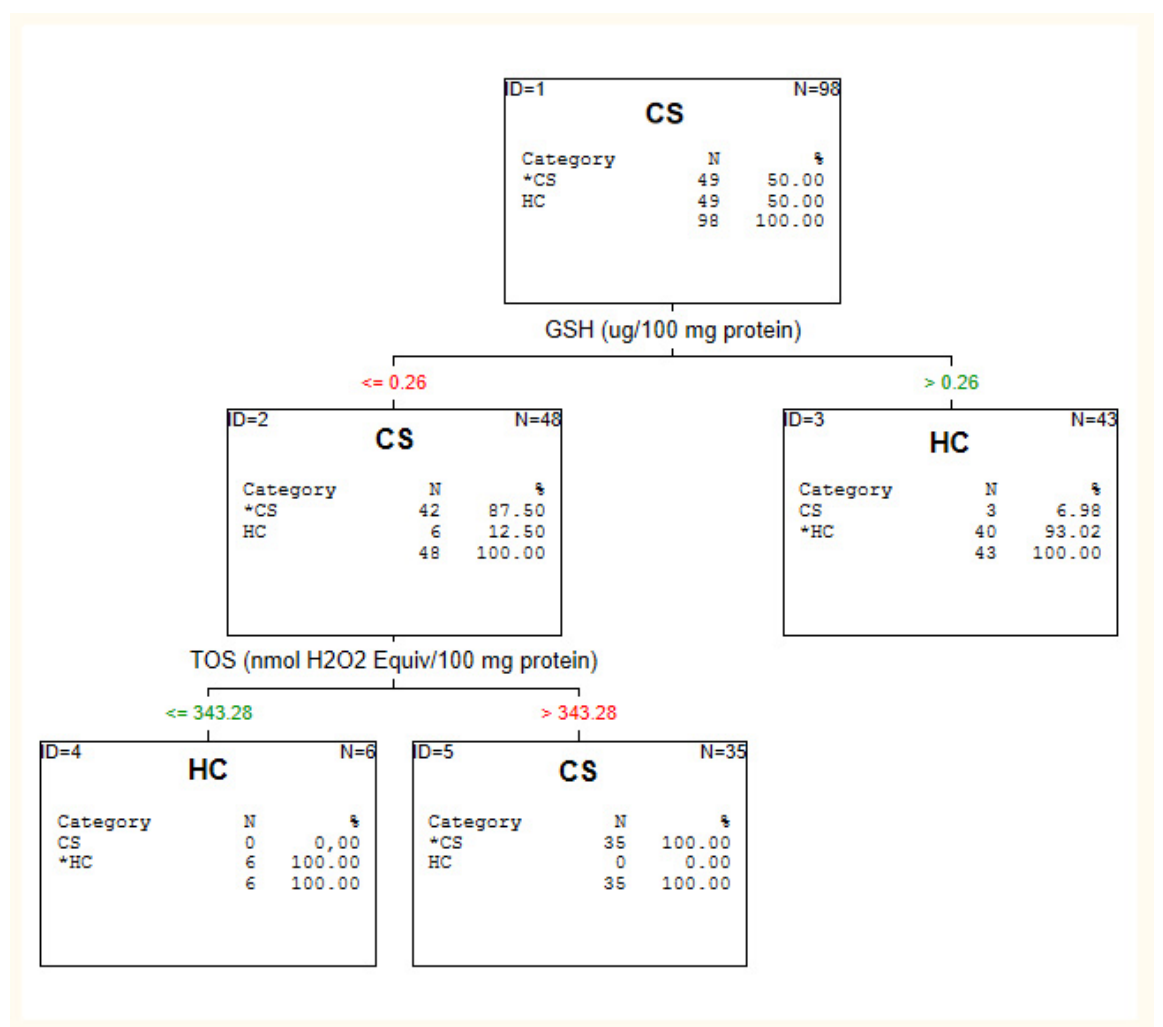
Figure 4. C&RT analysis for healthy individuals (HC) and chronic schizophrenia patients